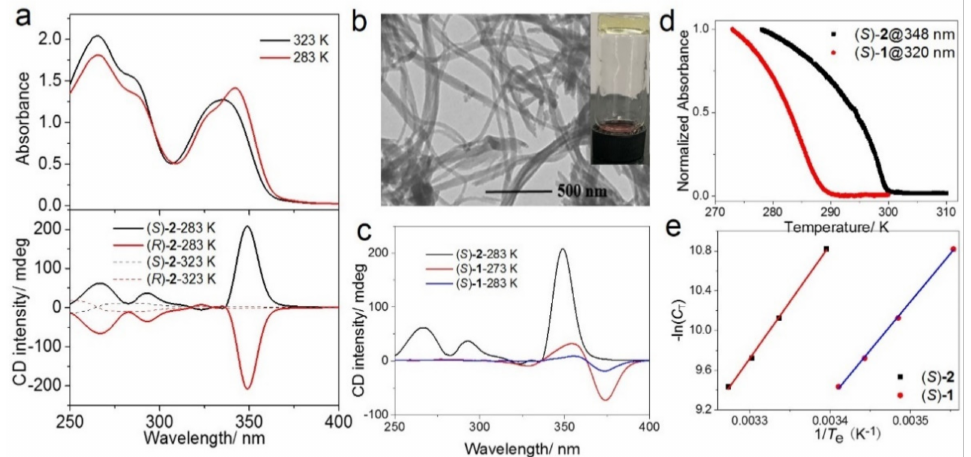
Figure 1. ( a ) upper, UV–Vis spectra of ( S )- 2 at 323 K (black line) and 283 K (red line); below, CD spectra of ( S )- 2 and ( R )- 2 at 323 K and 283 K (c = 0.04 mM in MCH). ( b ) TEM image (copper grid, 0.06 mM) of ( S )- 2 . Inset: organogel of ( S )- 2 at the concentration of 11.0 mM in MCH. ( c ) CD spectra (c = 0.04 mM in MCH) of ( S )- 2 at 283 K (black line), together with ( S )- 1 at 273 K (red line) and 283 K (blue line). ( d ) Normalized absorbance of ( S )- 1 and ( S )- 2 versus temperature upon cooling at a rate of 60 K h − 1 in MCH (c = 0.04 mM). ( e ) Van’t Hoff plots for ( S )- 1 and ( S )- 2 in